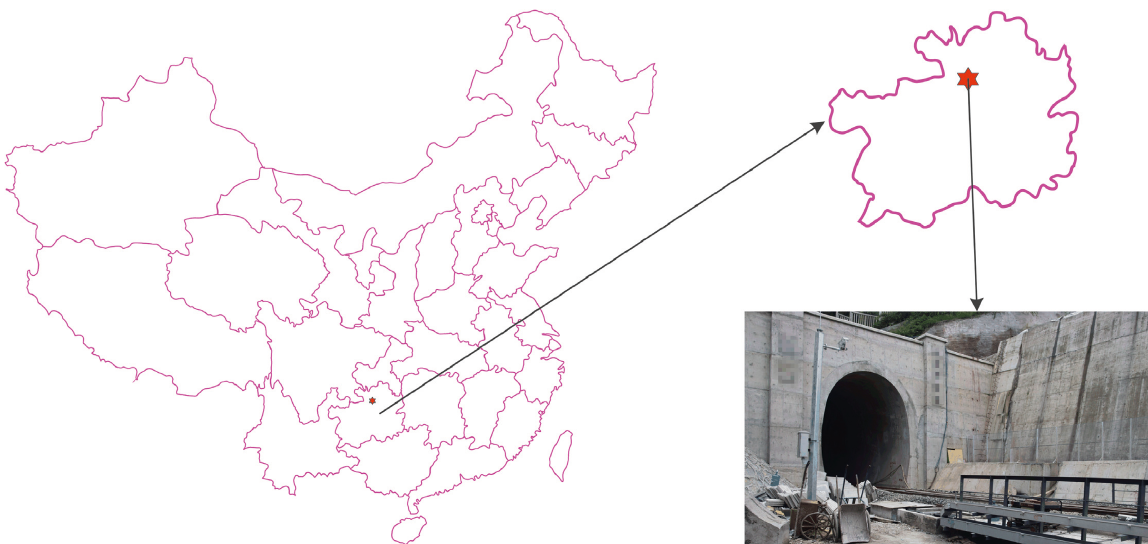
Figure 1: Location of the tunnel.